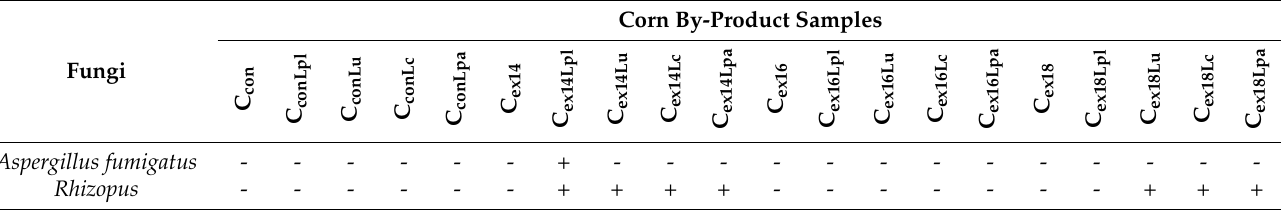
Table 7. Antifungal properties of non-treated and treated corn